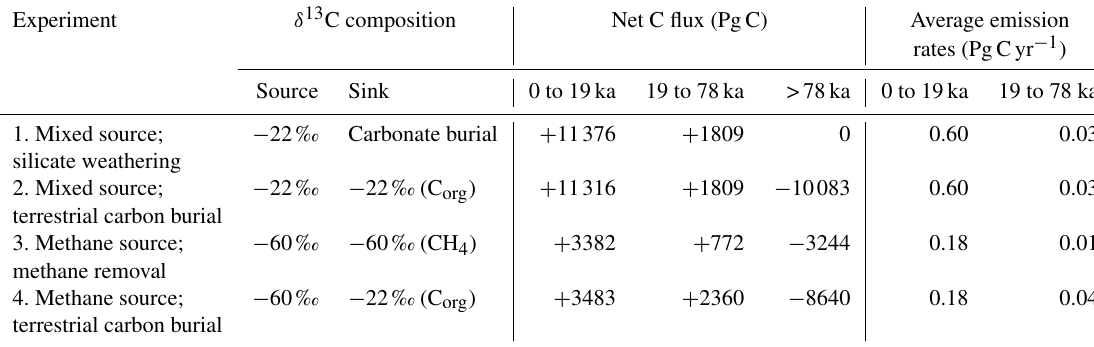
Table 1. Summary details of cGENIE simulations detailing isotopic compositions of source carbon input during the onset of the PETM to match the Zumaia CIE profile – and the nature of modelled CIE recovery, whether by silicate weathering only (Experiment 1), or by active carbon removal. The isotopic composition of this carbon removal (“Sink”) is also listed. Net C fluxes are calculated by the model to match the CIE profile and do not include carbon removed through silicate